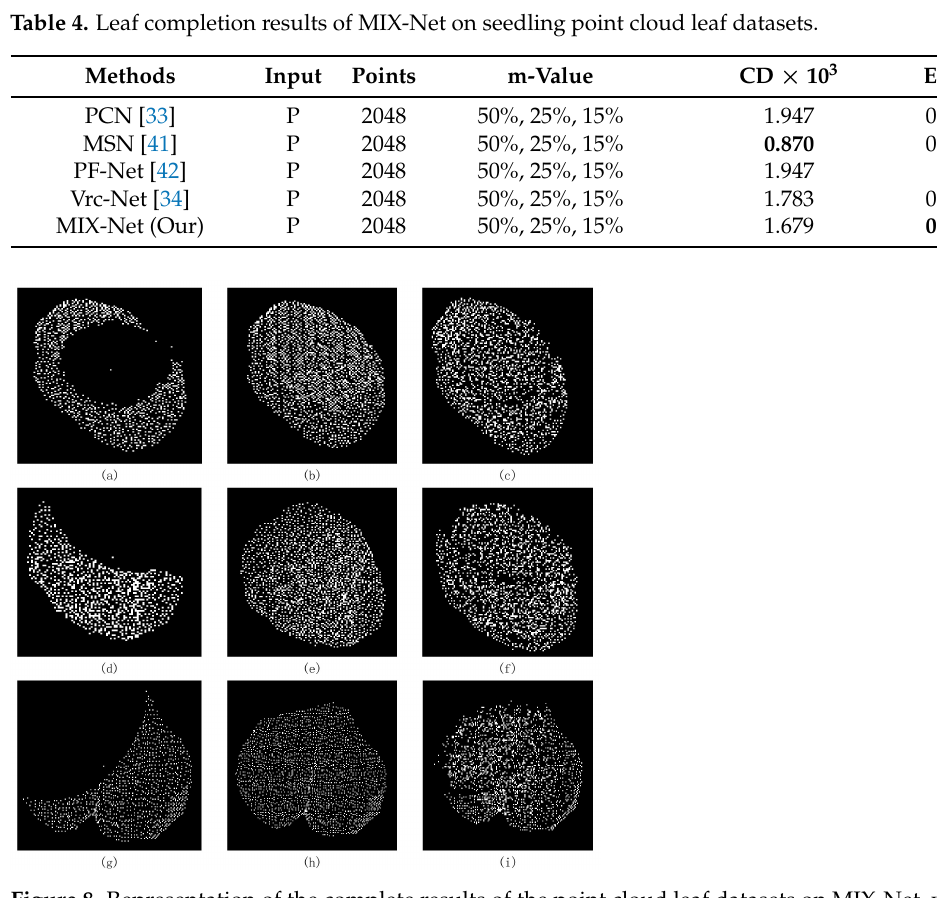
Figure 8. Representation of the complete results of the point cloud leaf datasets on MIX-Net, where ( a , d , g ) are the missing point cloud leaves from the input network, ( b , e , h ) are the real complete leaves, and ( c , f , i ) are the predicted outputs of the MIX-Net